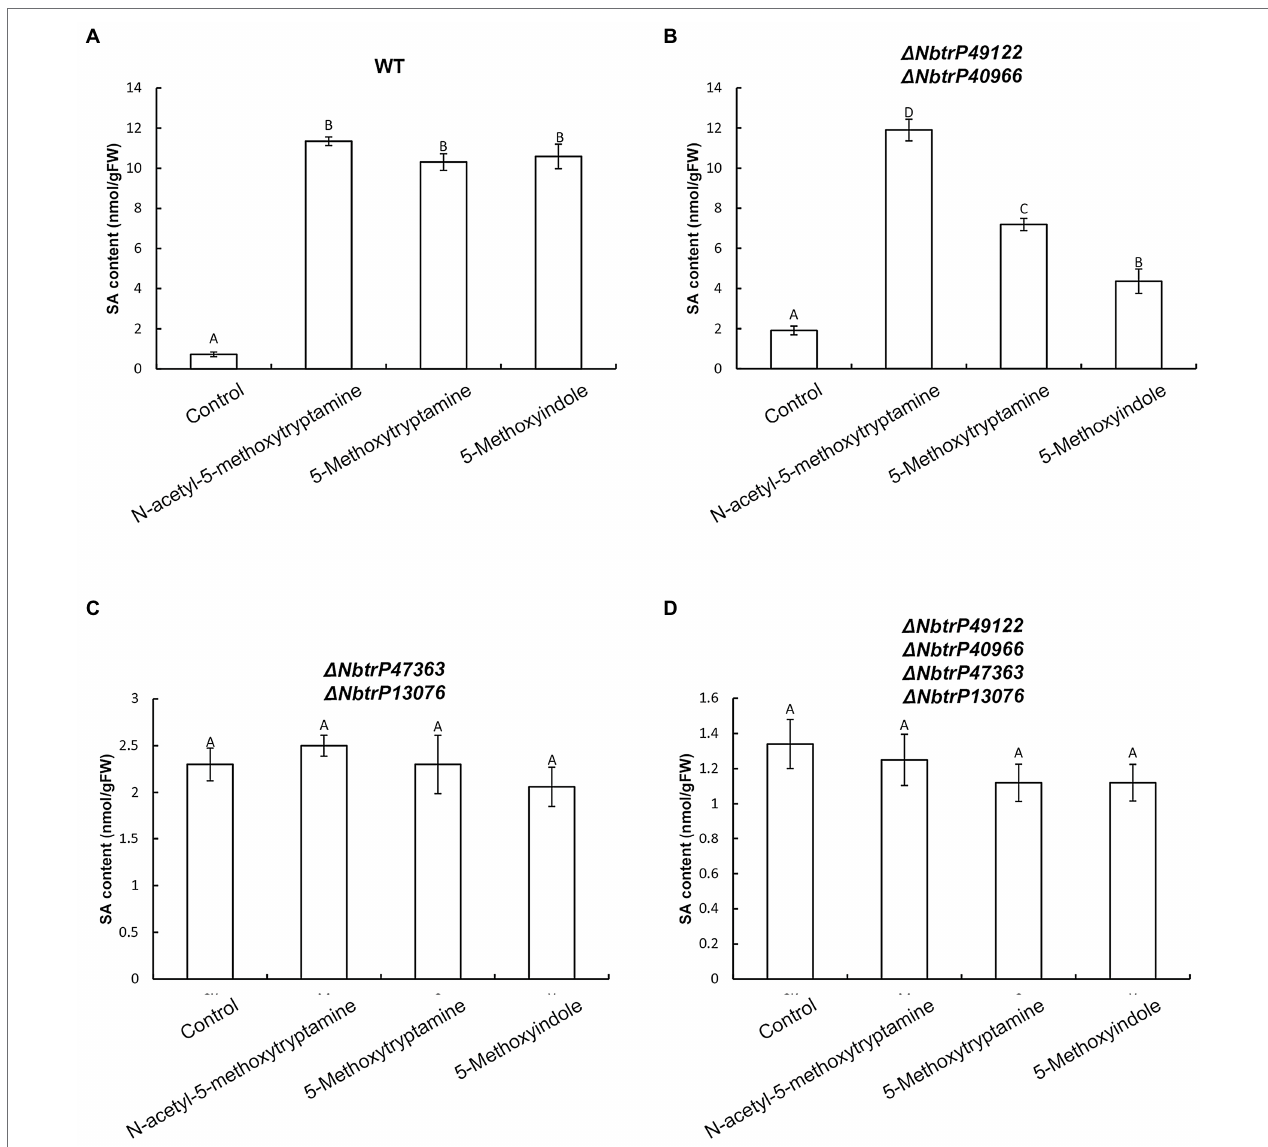
FIGURE 10 | The transmembrane receptors trP47363and trP13076 are involved in melatonin-, 5-methoxytryptamin-, and 5-methoxyindole-induced accumulation of SA. SA levels in leaves of wild-type and mutant lines of N. benthamiana treated the MT, 5-methoxytryptomine, or 5-methoxyindole. Levels of free SA in N. benthamiana wild-type plants (A) , the Δ NbtrP49122-trP40966 mutant (B) , the Δ NbtrP47363-trP13076 mutant (C) , and the Δ NbtrP47363-trP13076-trP49122- trP40966 mutant (D) . Data are the mean ± standard deviations (SDs; n = 3). Columns with different letters indicate significant differences between the treatment groups in the different lines of N. benthamiana as determined by a Duncan’s multiple range test ( p <